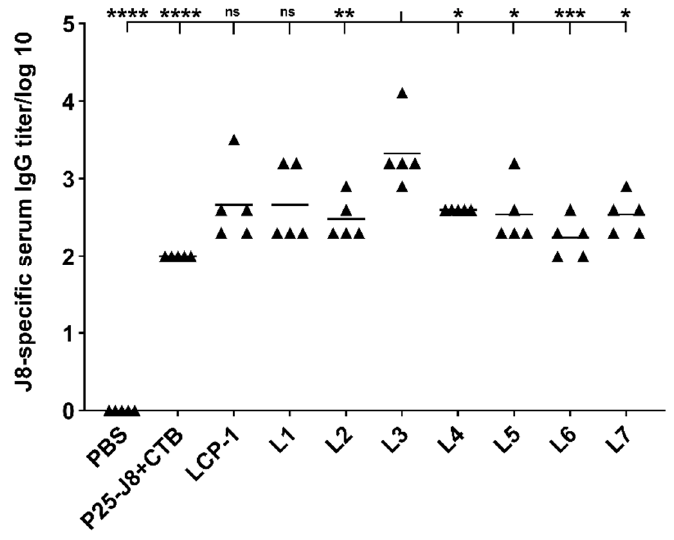
Figure 2. J8-specific antibody responses (log10) following intranasal administration of Tat 47–57 -based liposomes and controls in Swiss outbred mice (n = 5 per group), as determined by ELISA. Serum was collected at day 38 post-primary immunization. Statistical analysis was performed by one-way ANOVA followed by Tukey’s post hoc test to compare groups against L3 , as indicated. Not significant (ns), p > 0.05; *, p < 0.05; **, p < 0.01; ***, p < 0.001; ****, p < 0.0001.